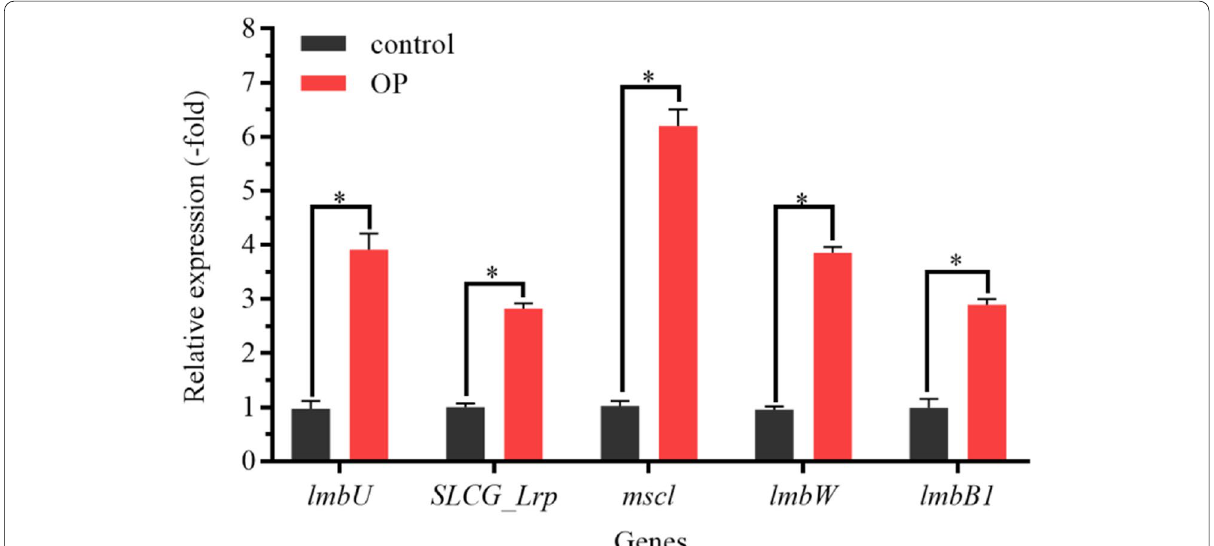
Fig. 5 Transcriptional analysis of the lincomycin biosynthetic genes and osmotic stress gene in Streptomyces lincolnensis grown in initial and optimized media. All gene transcription levels in the control were set to 1. * indicates statistical significance based on the two‑tailed test ( p < 0.05). Control: initial medium; OP: optimized